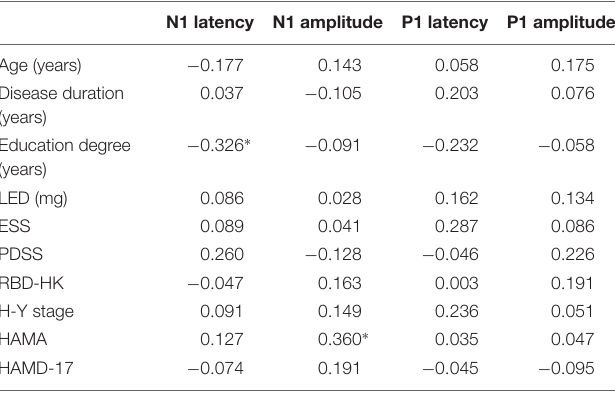
TABLE 4 | Correlation analysis between ERP amplitude and MOCA score in all participants (correlation coefficient r s ).